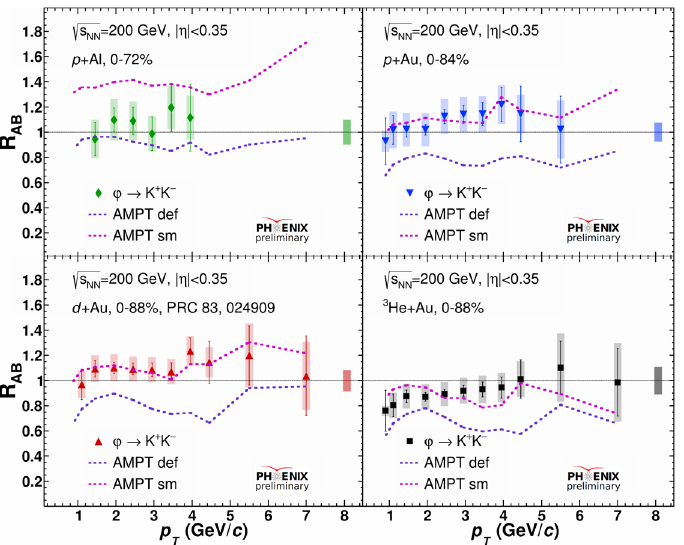
Figure 3: The comparison of φ meson R AB in p + Al, p + Au, d + Au, and 3 He + Au collisions at = 200 GeV at midrapidity ( p s NN string melting (sm) versions of the AMPT model